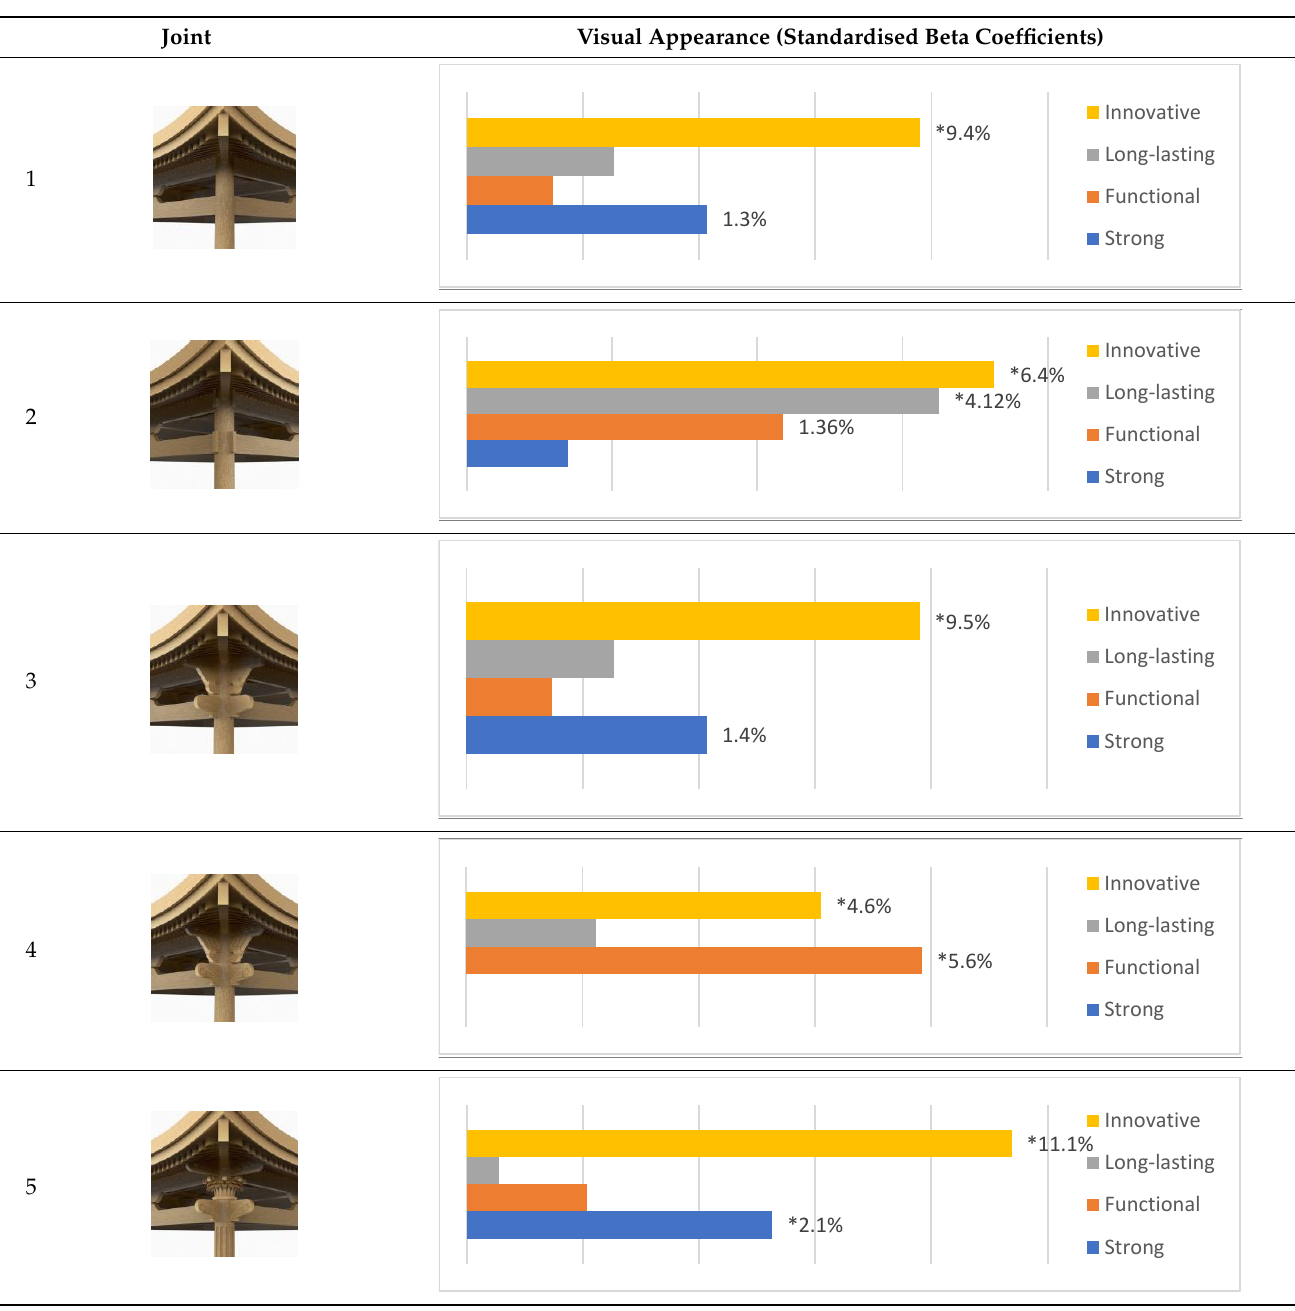
Table 4. Percentage of variance explained by visual appearance components in overall aesthetic preference for the timber joints.